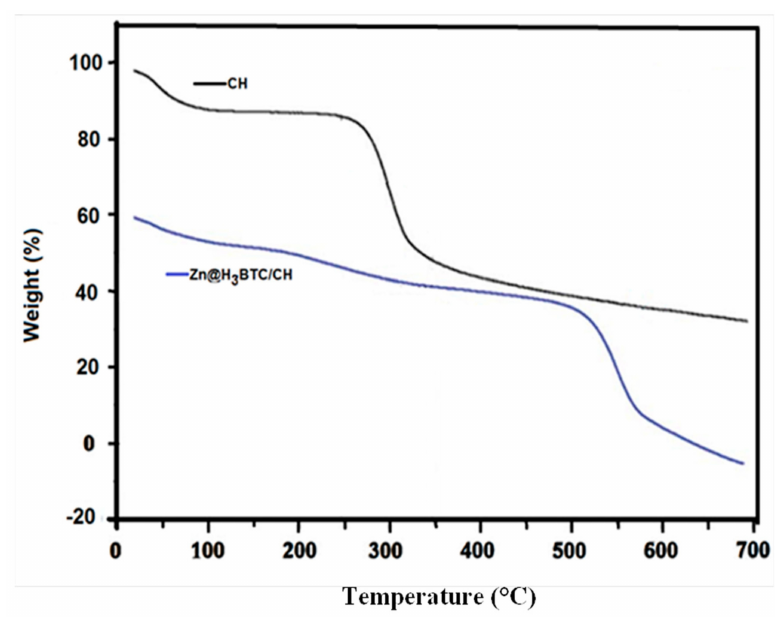
Figure 2. Thermogravimetric diagram of CH and CH/Zn@H 3